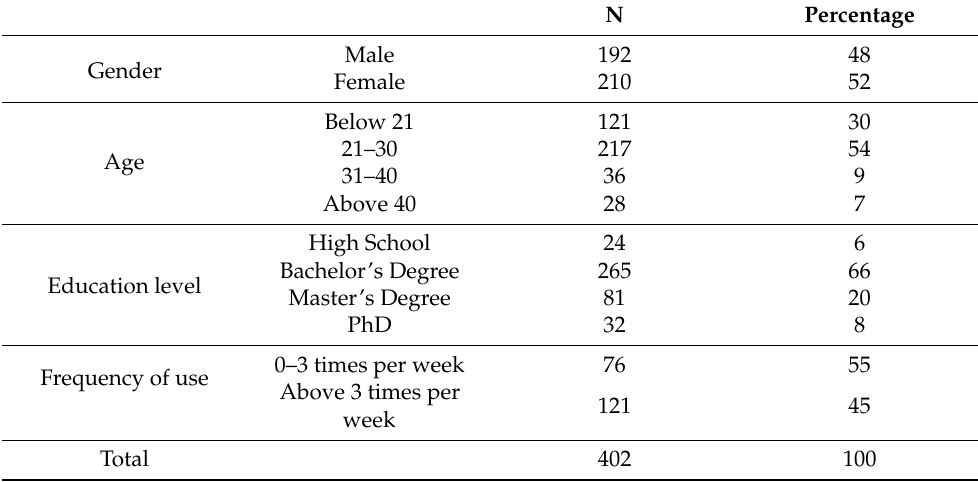
Table 2. Frequency